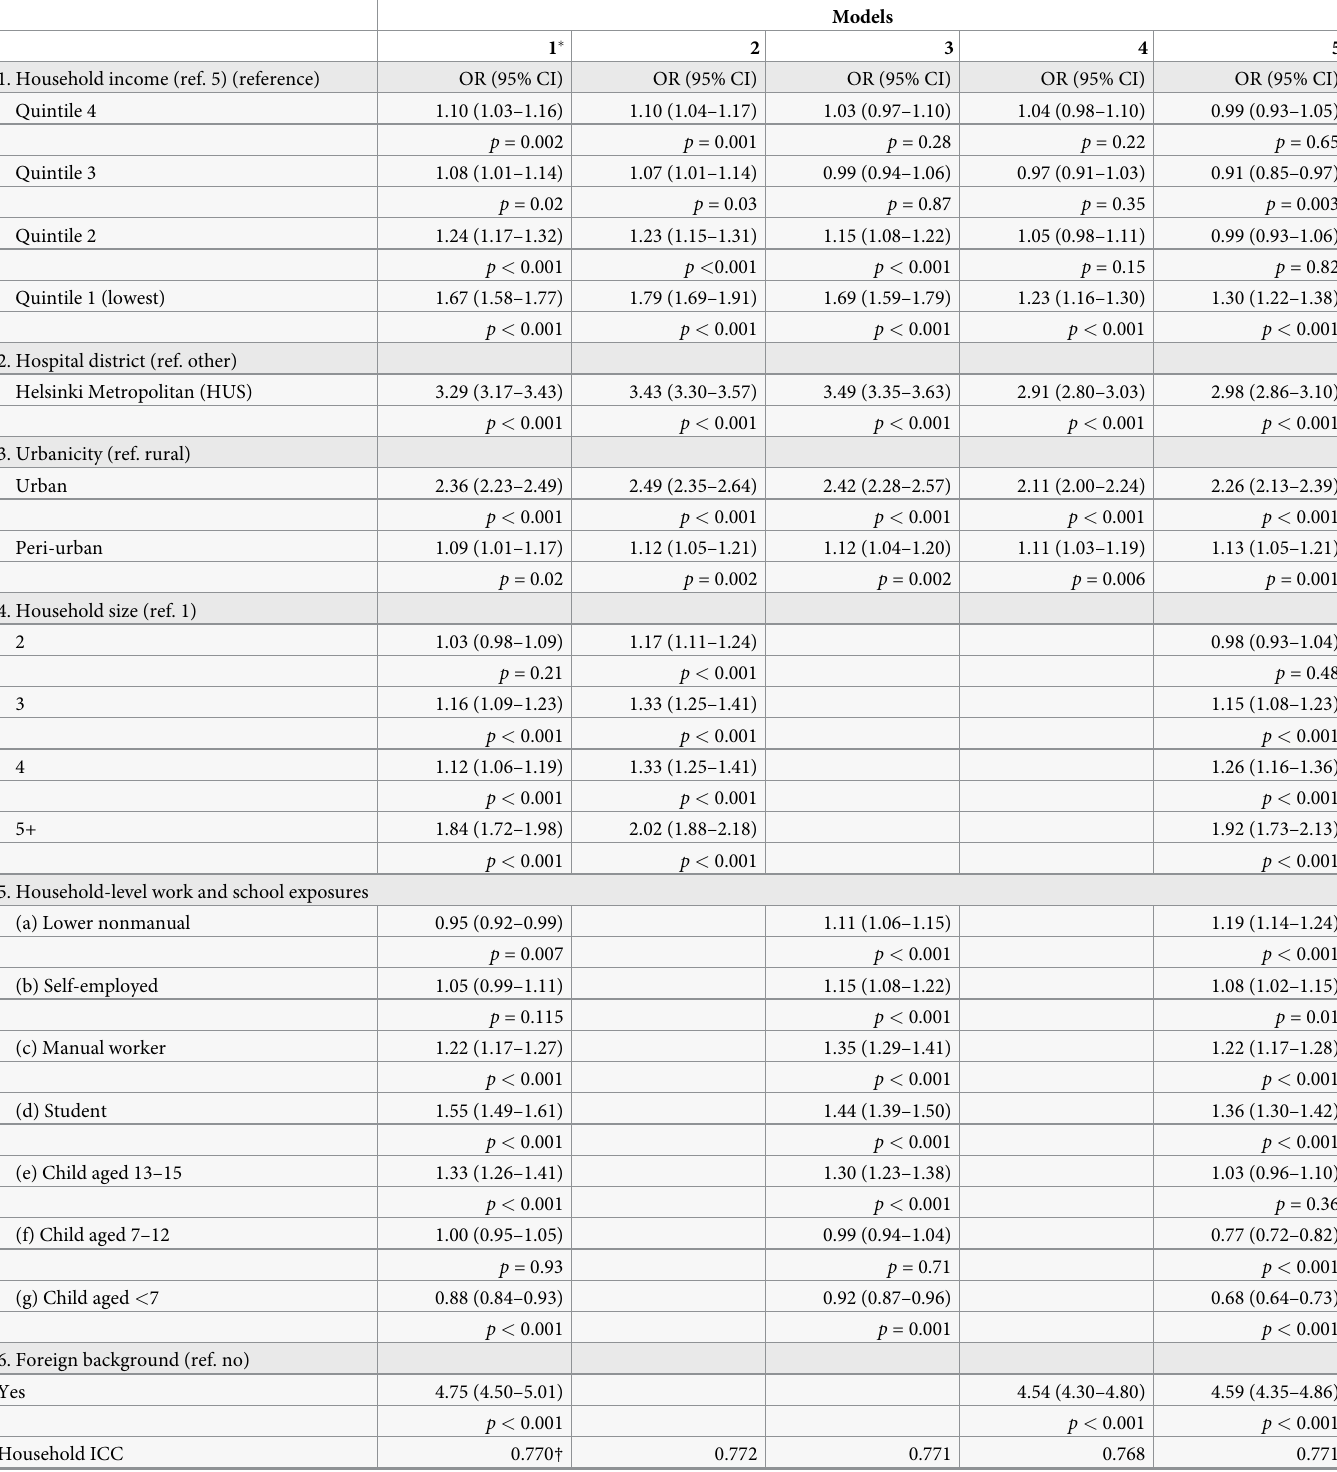
Table 1. Odds ratios of COVID-19 infection from 1 July 2020 to 22 February 2021 among individuals living in under-65